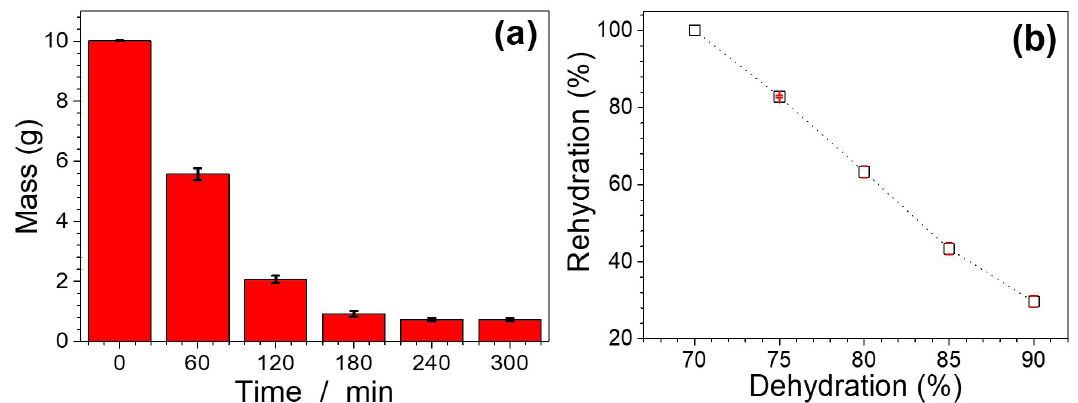
Figure 9. (a) Time evolution of the hydrogel dehydration at 65 °C, and (b) rehydration percentual after dehydration achieve 70, 75, 80, 85, and 90% of water